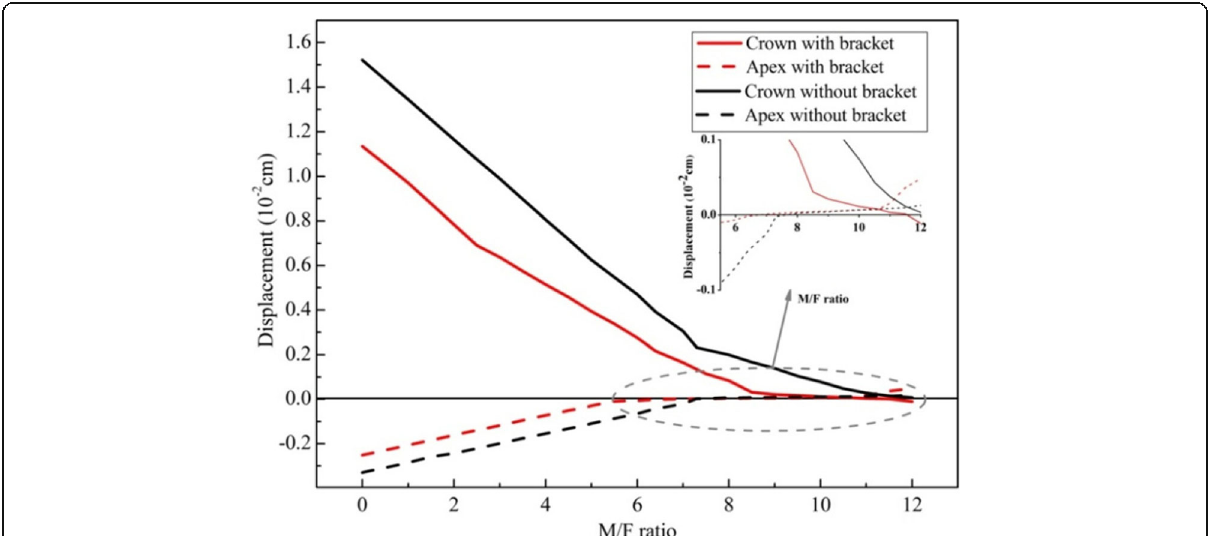
Fig. 4 Buccal-lingual displacements of the crowns and apices of the mandible canine, a force of 100 cN and the values of M/F ratio is increased